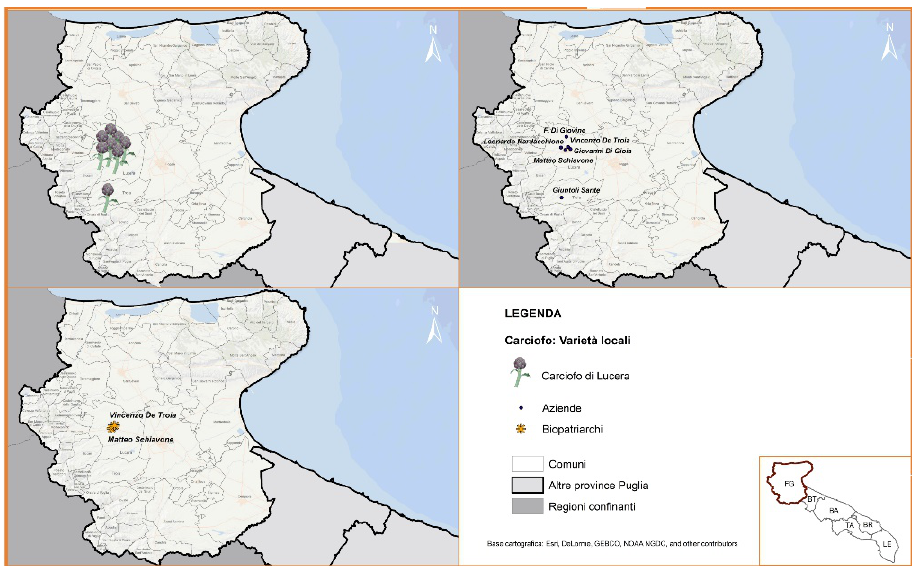
Figure 2. Distribution map of the ‘Carciofo di Lucera’ artichoke, generated by the management system of the project BiodiverSO (in Italian). The lower right quadrant reports the figure legend (Legenda), from top to bottom: Artichoke local varieties; “Carciofo di Lucera”; Farms; Bio-patriarchs; Municipalities (white rectangle); Other provinces in Puglia (light grey rectangle); Bordering regions (dark grey rectangle). Table 1. Morphological descriptors for the three populations according to UPOV and GIBA. The descriptors in red are the ones required for the entry in the conservation varieties